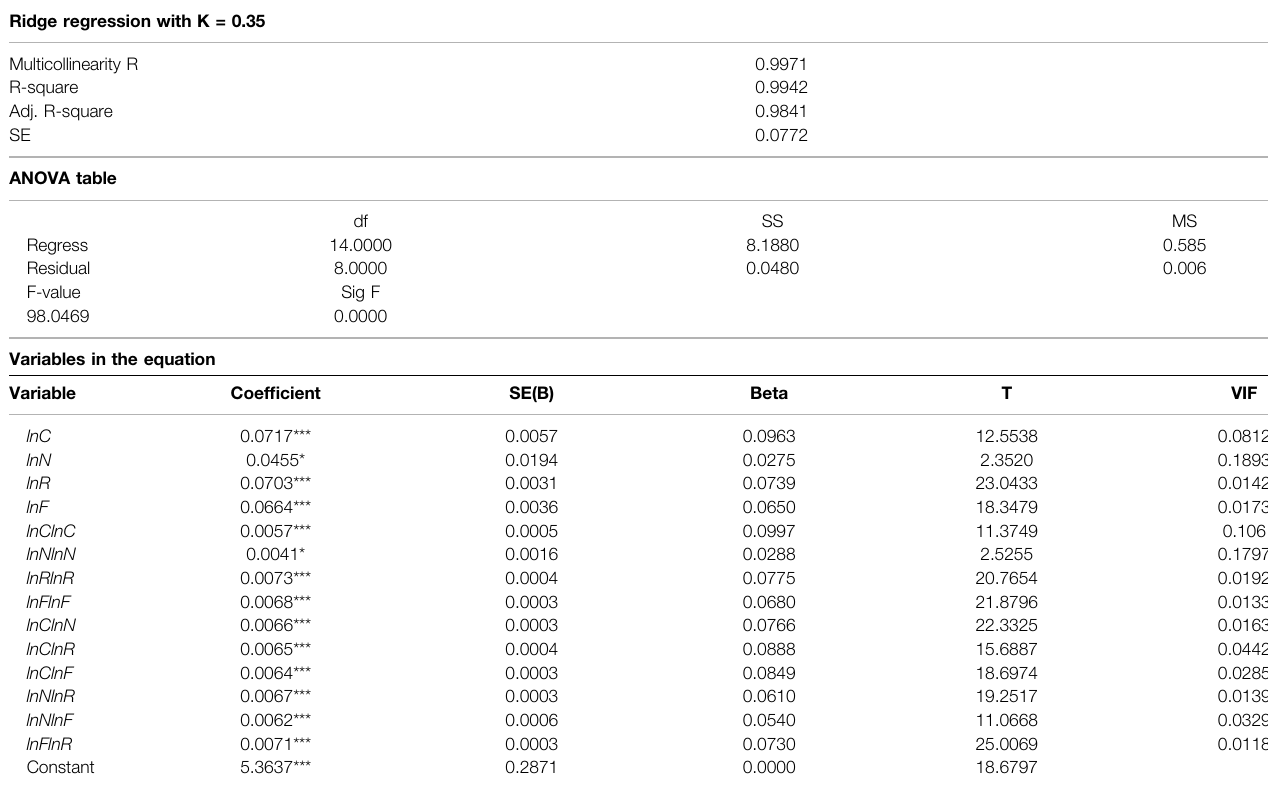
TABLE 2 | Ridge regression with K = 0.35. Ridge regression with K =